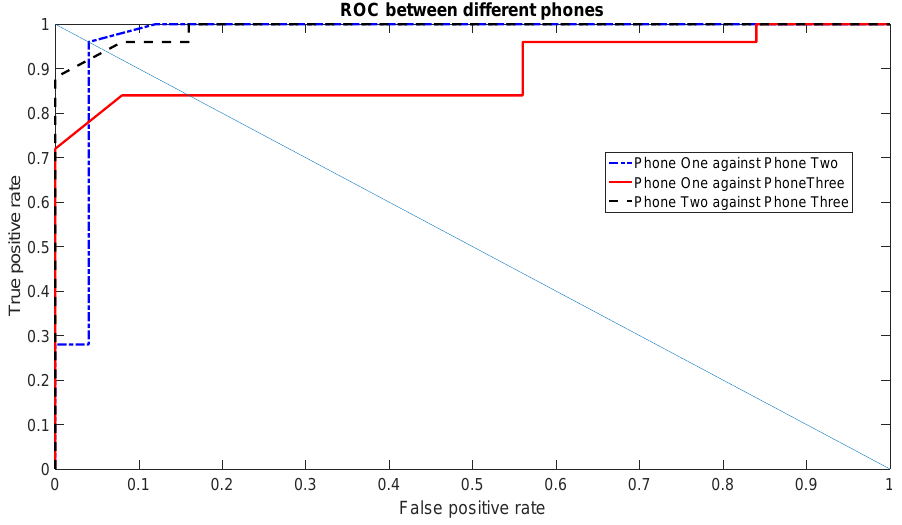
Figure 11. ROC among different phones using the first scenario for Gyroscope Y for a single day’s data in the first set of